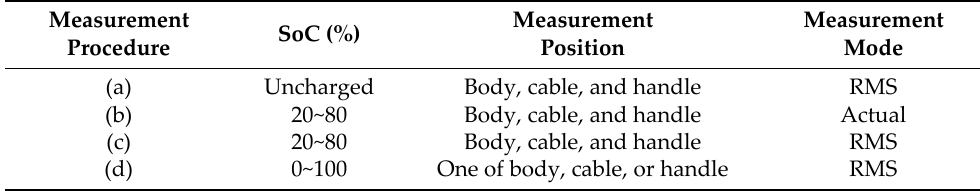
Figure 1. Measurement procedure for evaluation of exposure to electromagnetic fields in electric vehicle charging facilities. Table 3. Conditions for the measurement